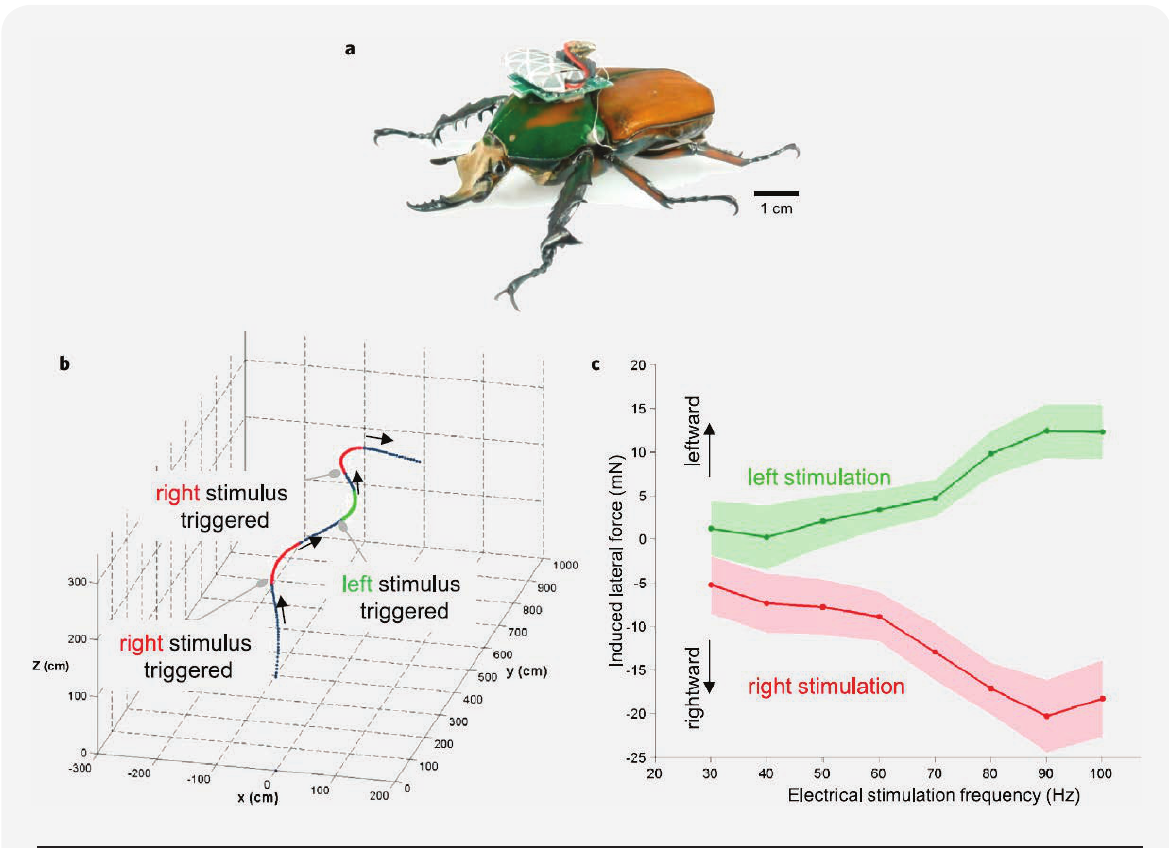
Figure 5. Flight directional control via stimulation of the third axillary (3Ax) muscles. (a) A live beetle with a miniature wireless backpack. The wires from the backpack were implanted into the left and right 3Ax muscles (working electrodes) and the mesothorax center hemolymph (counter electrode). (b) Electrical stimulation in sequence of the left and right 3Ax muscles produced left and right turns, respectively, resulting in a zigzag fl ight path. The black trajectory segments indicate periods of no stimulation. The red and green trajectory segments indicate right and left stimulation periods, respectively. (c) Electrical stimulation of the 3Ax muscle induced graded lateral forces in fl ight as a function of stimulus frequency. The green and red lines show the average lateral forces for left and right stimulations, respectively. A positive value denotes a leftward force and a negative value denotes a rightward force. The shaded areas denote the 95% confi dence